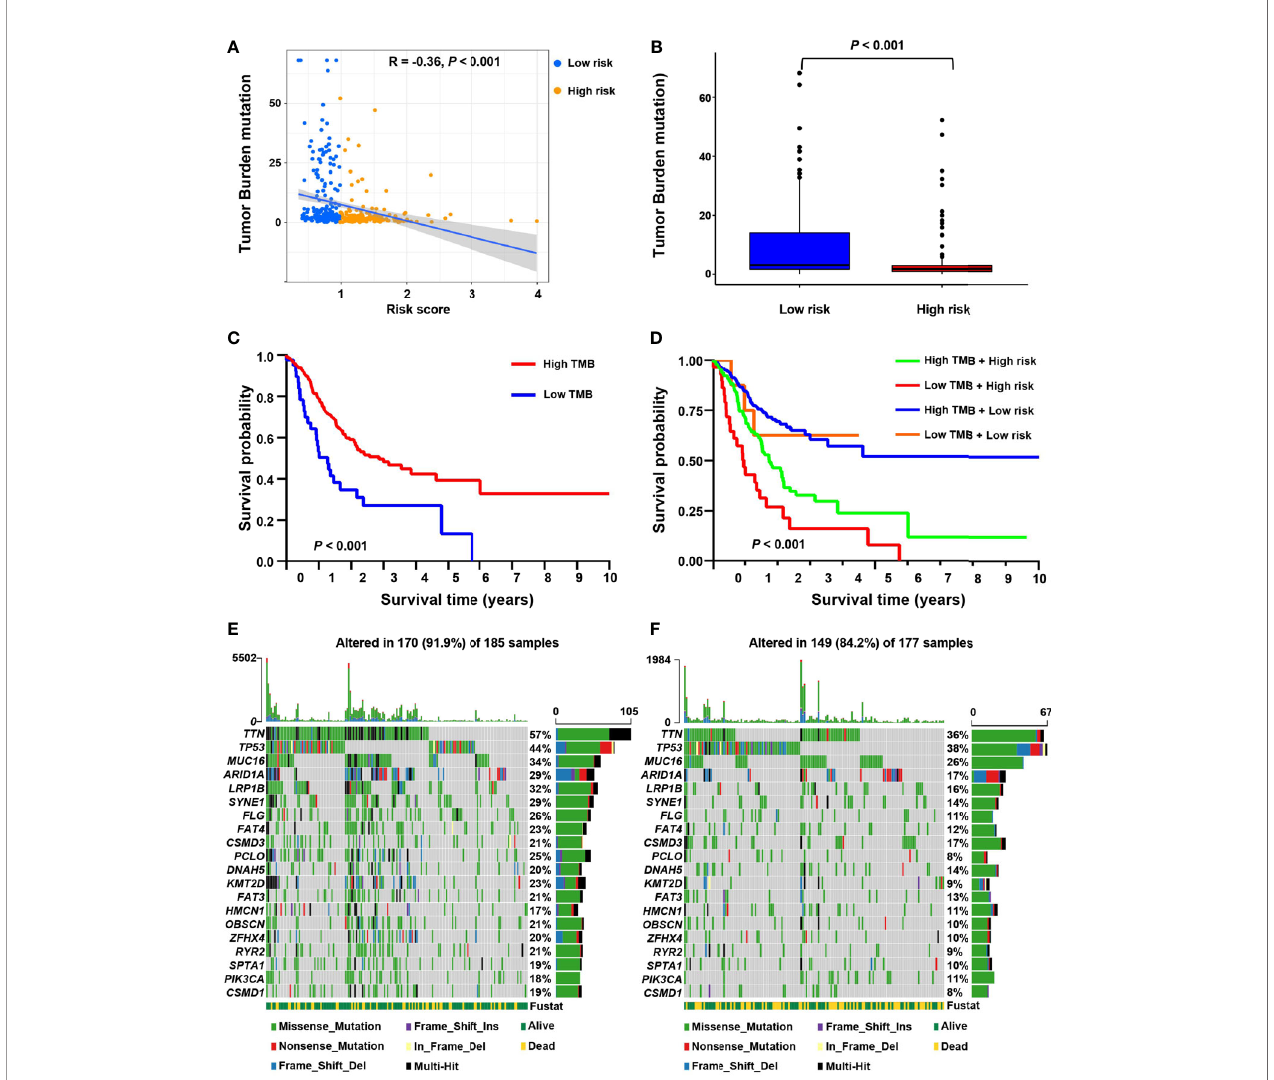
FIGURE 6 | The correlation between the risk score and somatic variants. (A) The scatter plot depicts the negative correlation between risk score and tumor mutation burden (TMB) in the screening cohort. (B) TMB difference in the high-risk and low-risk groups. (C) Kaplan-Meier curves for high-risk and low-TMB groups of the screening cohort. (D) Kaplan-Meier curves for patients in the screening cohort strati fi ed by both risk score and TMB. (E, F) Waterfall plots display the frequently mutated genes in low-risk and high-risk groups in the screening cohort. The left panel shows the genes ordered by their mutation frequencies. The right panel presents different mutation